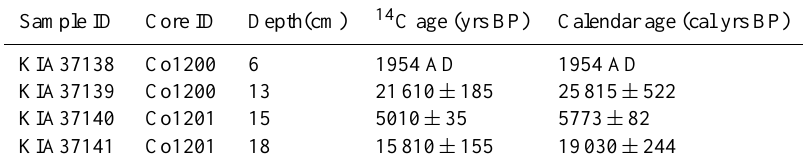
Table 1. Radiocarbon ages and calendar ages inferred using CalPal-2007online (Danzeglocke et al., 2008) of plant macrofossils from cores Co1200 and Co1201.